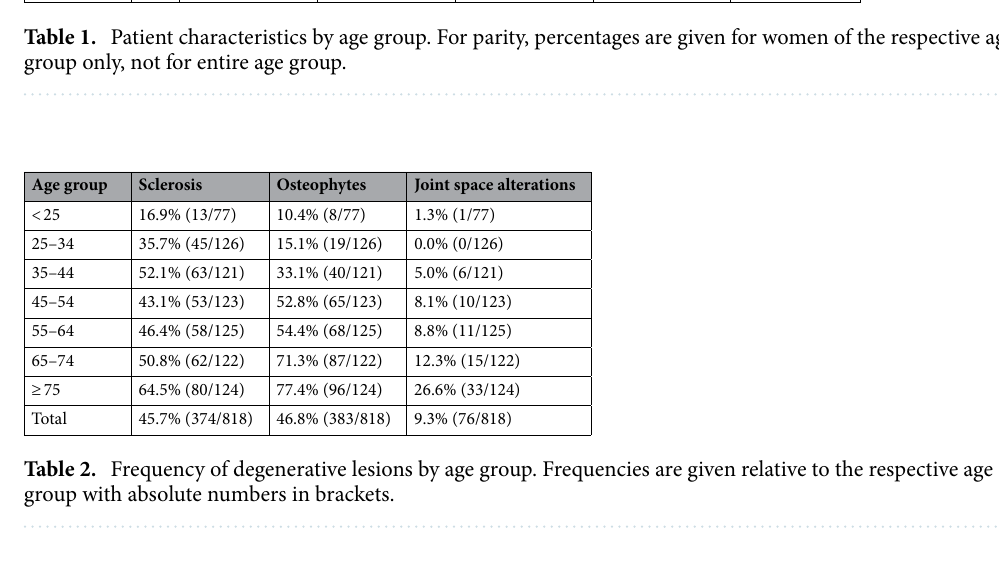
Table 2. Frequency of degenerative lesions by age group. Frequencies are given relative to the respective age group with absolute numbers in brackets.